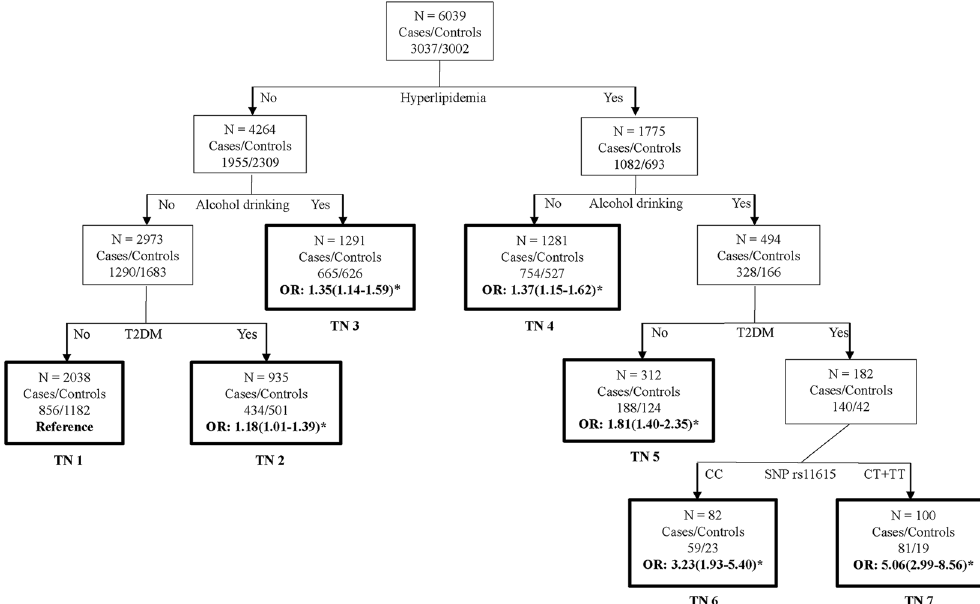
Figure 1. Classification and regression trees for alcohol drinking, history of T2DM and hyperlipidemia and SNP rs11615 in all participants of our study. Terminal nodes (TN) are thick bordered. ORs and 95% CIs were calculated by logistic regression after adjusting for age, sex, BMI, smoking, alcohol drinking and histories of hypertension, hyperlipidemia and T2DM, * P <